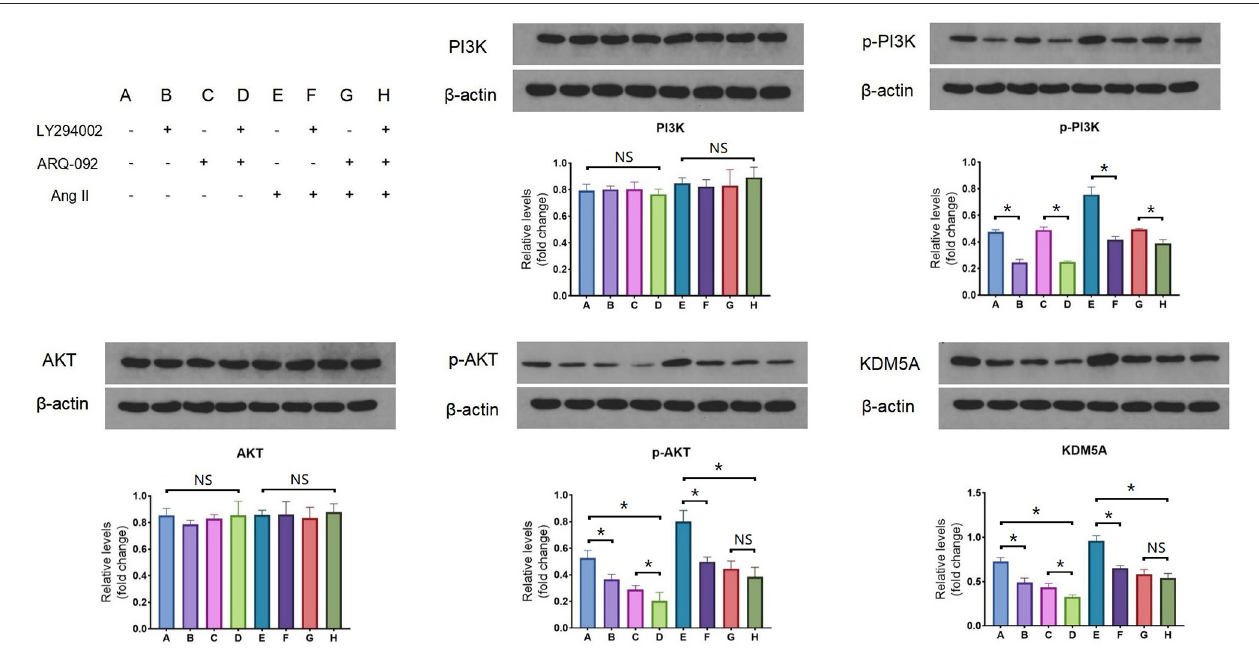
FIGURE 1 | Western blotting results of PI3K, p-PI3K, AKT, p-AKT and KDM5A protein expression in CFs treated with Ang II, LY294002, and ARQ-092. LY294002 (20 µ mol/L) is an inhibitor of PI3K; ARQ-092 (10 µ mol/L) is an inhibitor of AKT. Beta-actin was used as the reference gene. Each data point was obtained from three replicate experiments. * P <